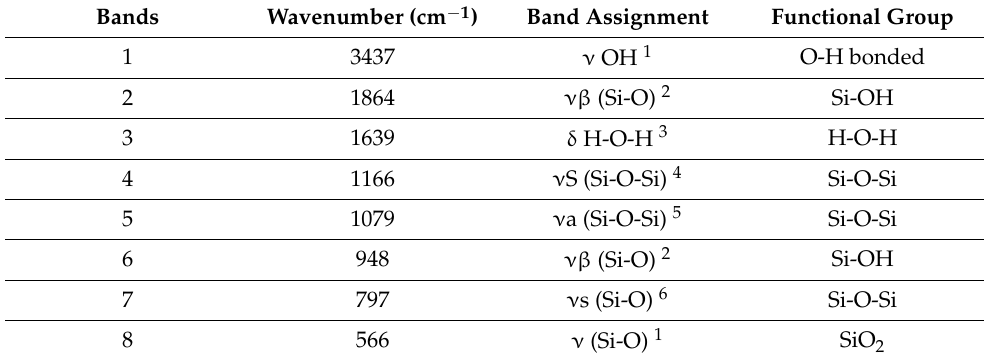
Table 6. FT ₋ IR of silica synthesized with acetic acid (KZ1). Table 6. FT-IR of silica synthesized with acetic acid